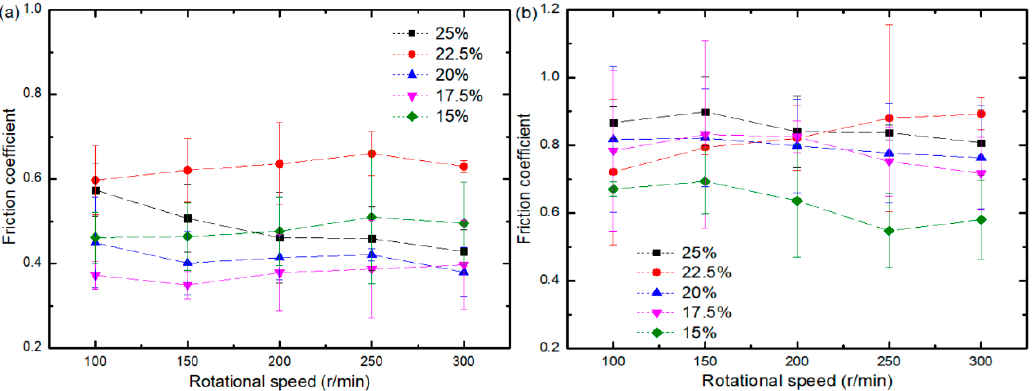
Figure 9. The friction coefficient of composites with different initial solid phase content at different speeds: ( a ) Water-based drilling fluid; ( b ) Dry friction.